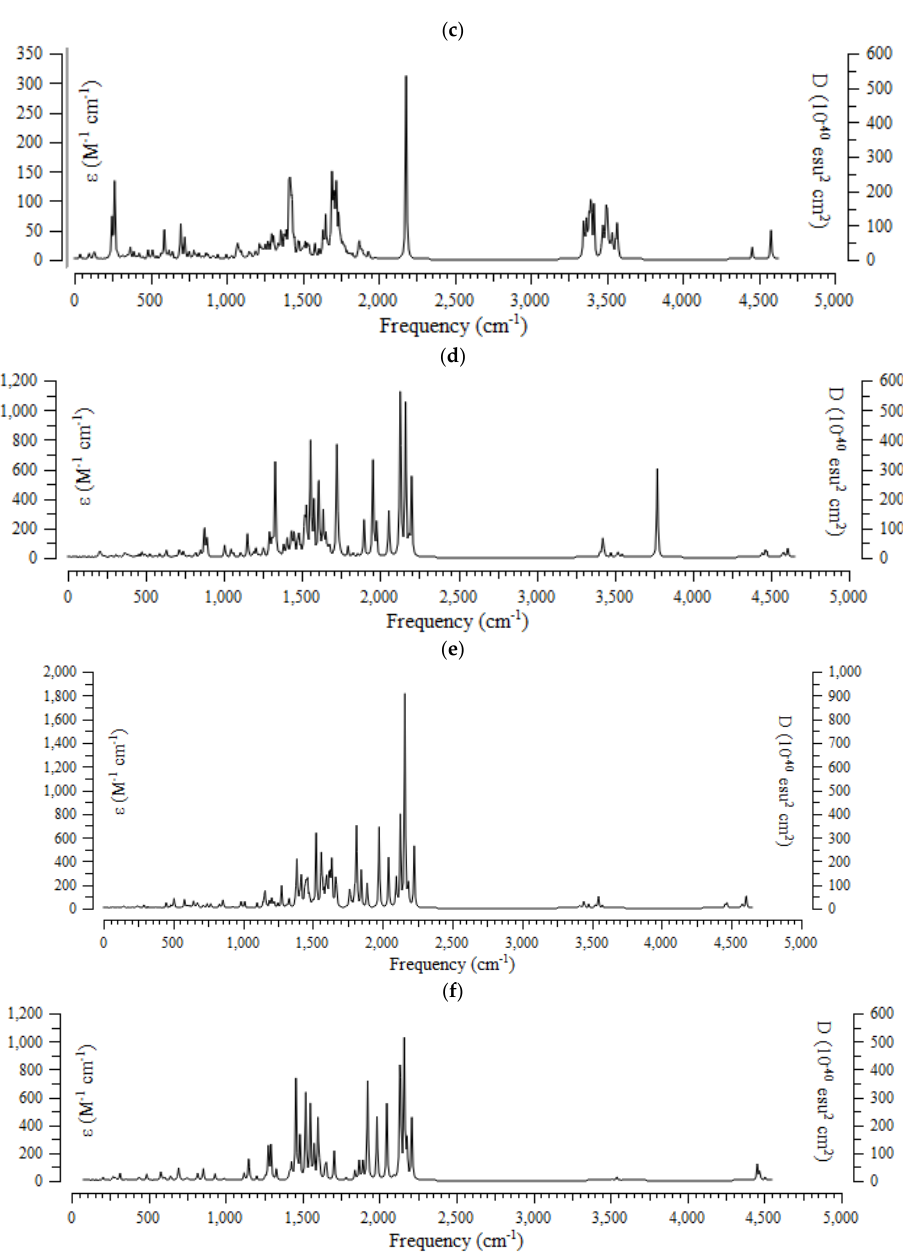
Figure 3. The infrared spectra of effective compounds in Sarracenia purpurea drug including ( a ) (+)-catechin, ( b ) betulinic acid, ( c ) ursolic acid, ( d ) quercetin-3-O-galactoside, ( e ) luteolin-7-O-glucoside, and ( f ) myricetin adsorbed onto the surface of (6,6) armchair CNT by using 6-311+G(2d,p) calculations. The results of physical and thermodynamic properties of dipole moment, ∆ H, ∆ G and ∆ S for (+)-catechin, betulinic acid, ursolic acid, quercetin-3-O-galactoside, luteolin-7- O-glucoside, and myricetin, adsorbed onto the surface of (6,6) armchair CNT using the B3LYP/6-311+G(2d,p) method, are represented in Table 2 and Figure